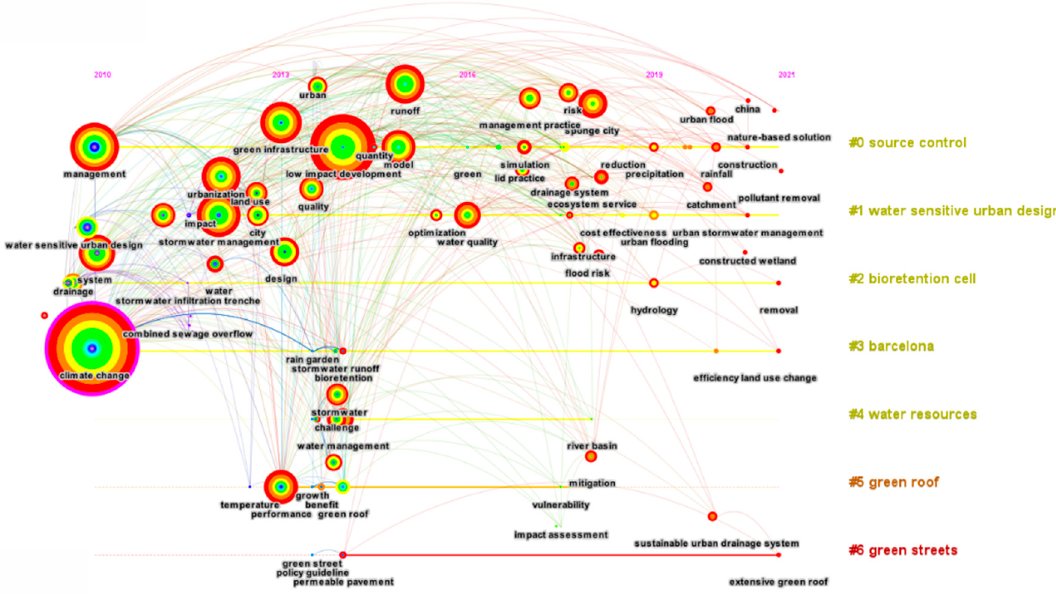
Figure 10. Climate keyword clustering timeline analysis.